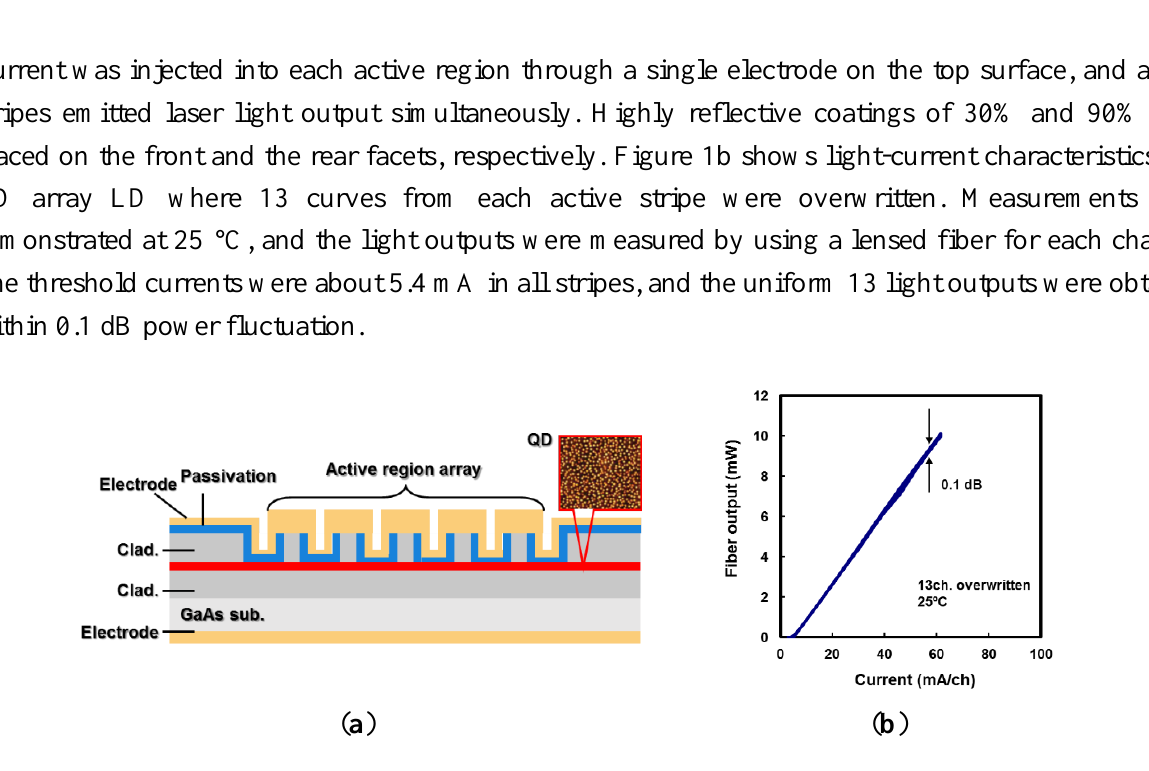
Figure 1. Structure and characteristics of a QD array LD: ( a ) Schematic structure. ( b ) Light-current characteristics. Thirteen curves were overwritten.